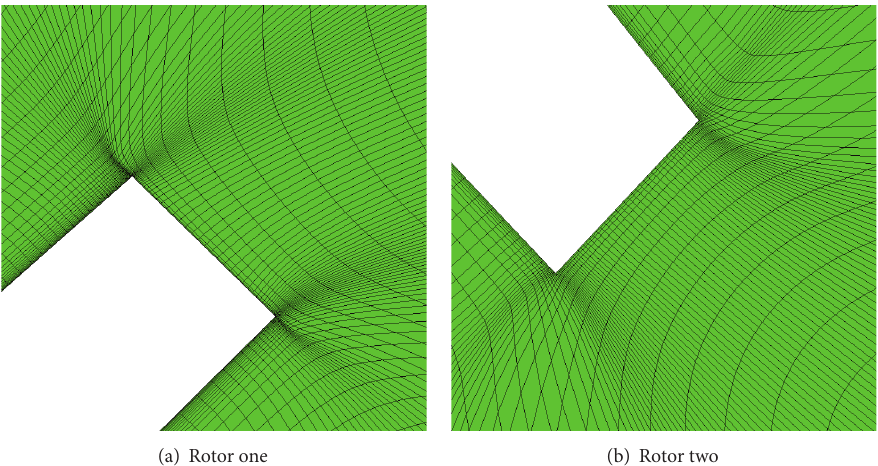
F 3: Midspan rotor grids at the trailing edge.